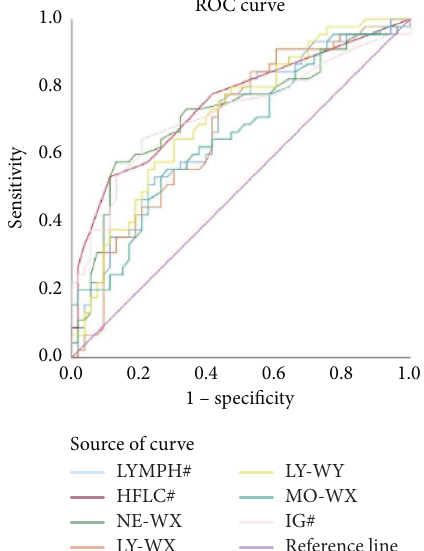
Figure 1: ROC curve for diferential diagnosis of leukocyte parameters between sepsis and nonseptic infection.